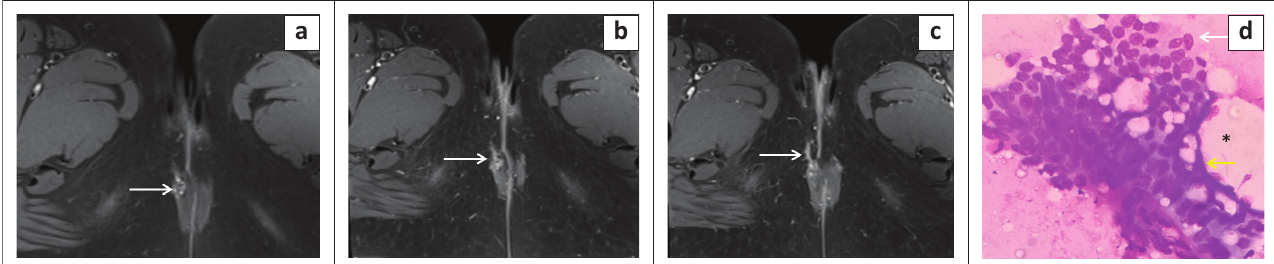
FIGURE 8: (a–d) Pre-contrast fat suppressed T1W image (a), shows hyperintense areas of haemorrhage (arrow). Serial axial (b and c) post-contrast fat suppressed T1W images demonstrate heterogeneous enhancement (arrow). FNAB specimen of the lesion (d, 600× magnification) reveals clusters of cells having well-formed acini (white arrow) mixed with stromal cells (yellow arrow) and surrounding adipocytes (asterisk) confirming